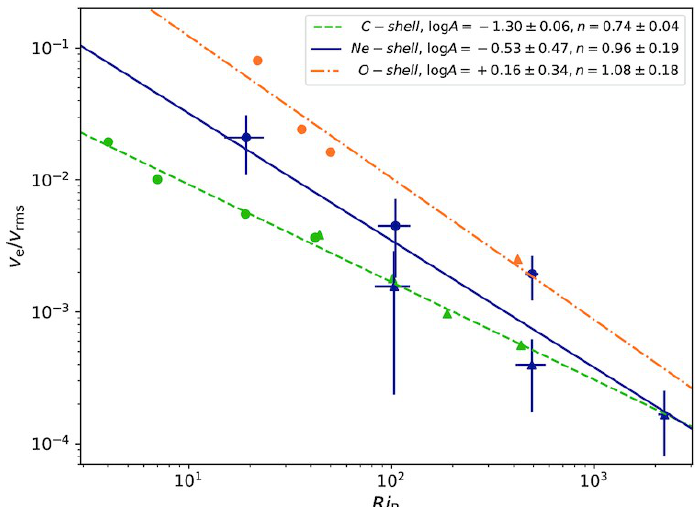
Figure 7. Entrainment rate is plotted against the bulk Richardson number for simulations of neon burning shells [31], oxygen burning shells [25], and carbon burning shells [150]. Entrainment laws ( 0.05,1 ) and n with A 1 are reported. Figure 5 of Rizzuti et al. [31]; © Oxford University ARi − n B ∼ ∼ Press. Reproduced with